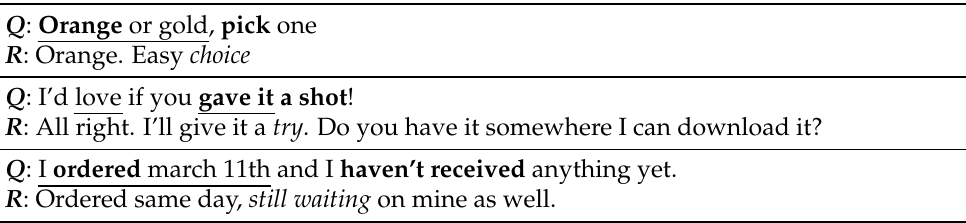
Table 1. The examples which show that the response context affects response generation in the Reddit data